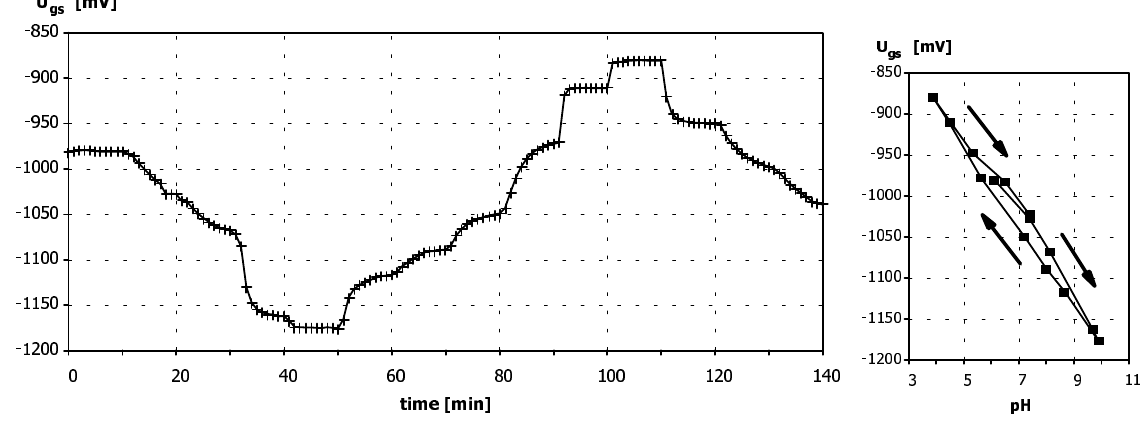
Figure 4. Dynamic response and calibration curve to pH of an ISFET with polyHEMA coating ca. 20 µm thick, deposited according to the Method 3. Cycle of pH changes: 6-10-4-7.